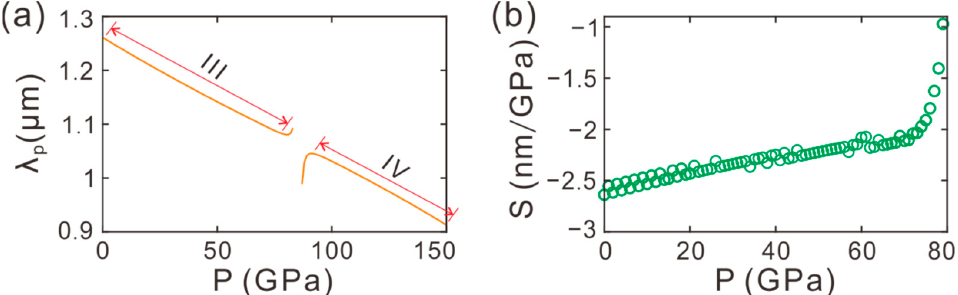
Figure 4. ( a , b ) Central wavelength of the defect mode and sensitivity coefficient of sensors changing with the stationary pressure intensity at the environment temperature Te = 100 K. Periodic number is N = 3.